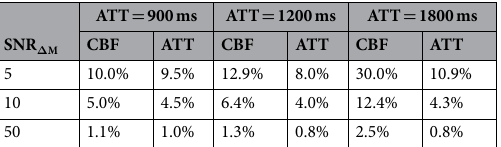
Table 4. Coefficient of variation of multi-PLD-derived CBF and ATT as predicted by computer simulation. Based on the previously reported model 24 , PCASL signal ( Δ M) was generated for each combination of signal- to-noise ratio (SNR Δ M = 5, 10, and 50, representing low SNR, average SNR, and almost noise-free conditions, respectively) and ATT (900, 1200, and 1800 ms, approximately covering the range previously reported). For each combination, 1000 multi-PLD datasets were generated and yielded 1000 estimates of CBF and ATT, from which coefficient of variation was calculated to assess measurement